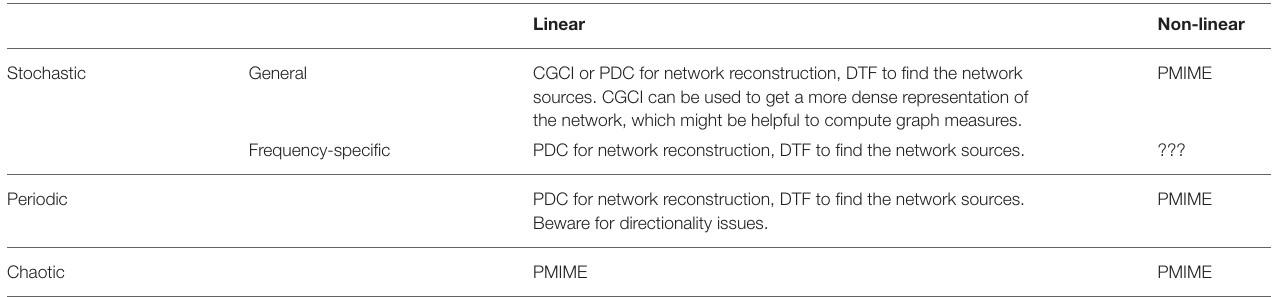
TABLE 1 | Overview of the different signal characteristics covered in this paper, in terms of generative processes and interaction types, and the causality measures that were found to perform best under these circumstances in the simulation